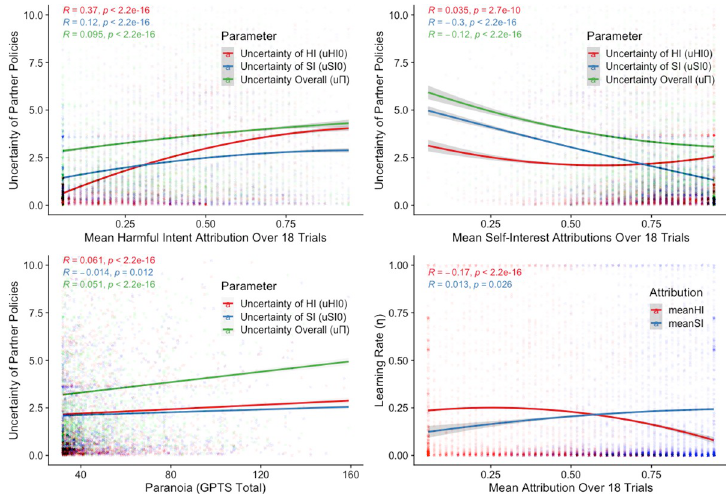
Fig 3. Spearman rank correlations between uHI0, uSI0, u P , and η , and pre-existing paranoia and in-the-moment attributions. (A) Quadratic fit for uncertainty of partner policies across the mean harmful intent attributions scored over 18 trials. (B) Quadratic fit for uncertainty of partner policies across the mean self-interest attributions scored over 18 trials. (C) Linear fit for uncertainty of partner policies across GPTS scores. (D) Quadratic fit of learning rate by mean attributions scored over 18